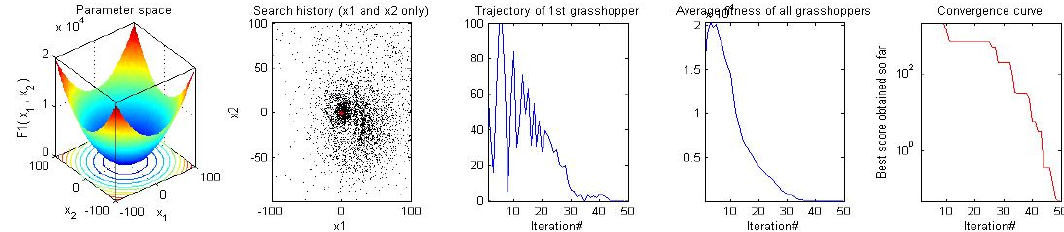
Figure 2. HAGOA search behavior on unimodal function (F1)